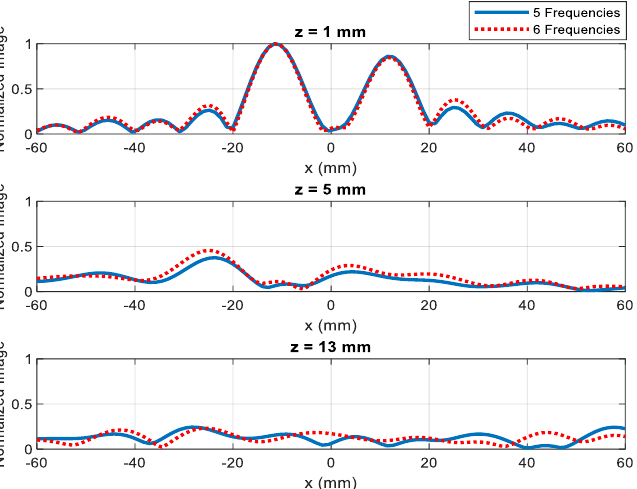
Figure 14. Reconstructed 1D images for copper strips placed at a depth of 1 mm when using data at 5 and 6 resonant frequencies.